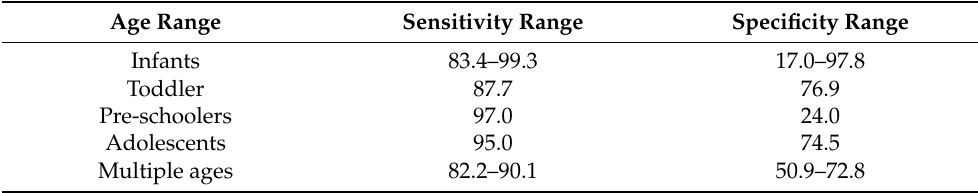
Table 1. Age-specific sensitivity and specificity of actigraphy to detect